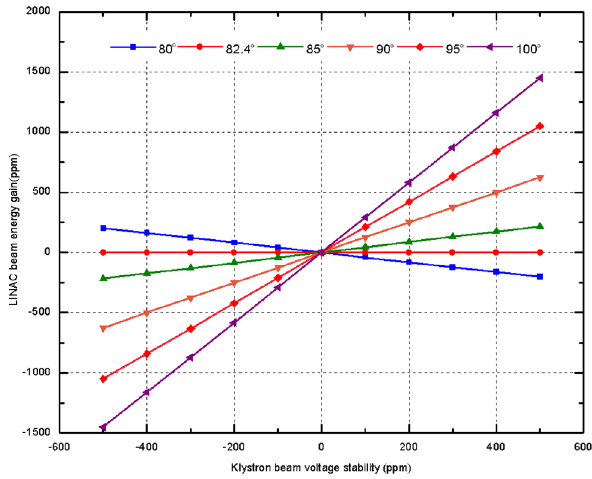
Fig. 6 Phase tolerance vs. beam voltage stability of a C-band klys- tron